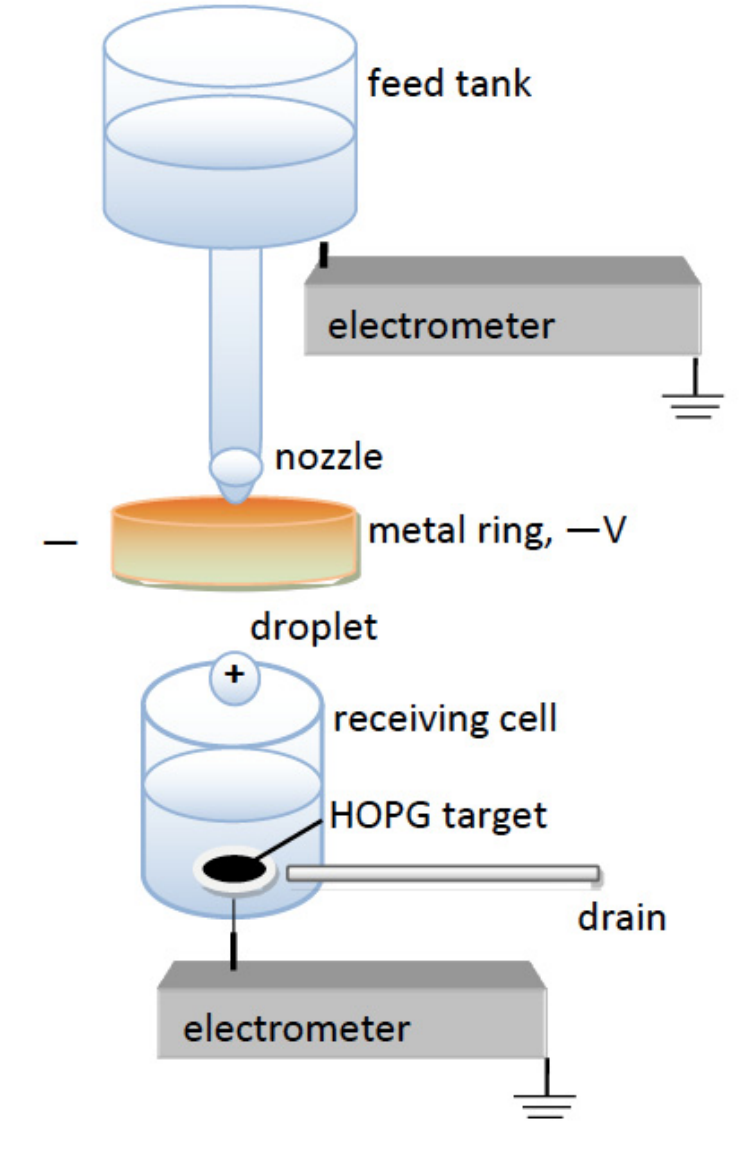
Figure 1. Experimental setup.